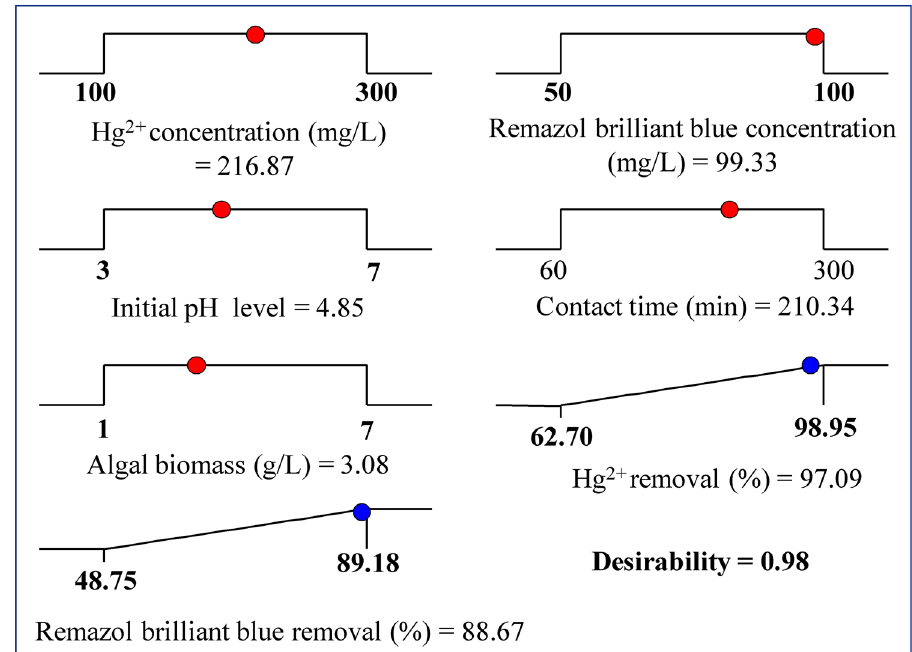
Figure 6. The optimization plot displays the desirability function and the optimum predicted values for the maximum simultaneous biosorption of Hg 2+ and Remazol brilliant blue dye by Gelidium corneum biomass.